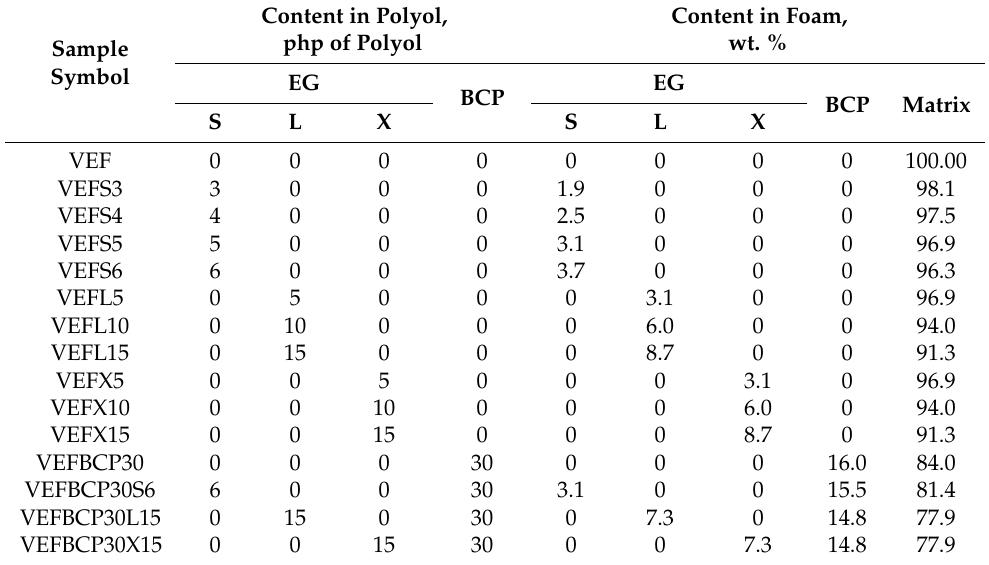
Table 3. Composites of viscoelastic polyurethane foams with